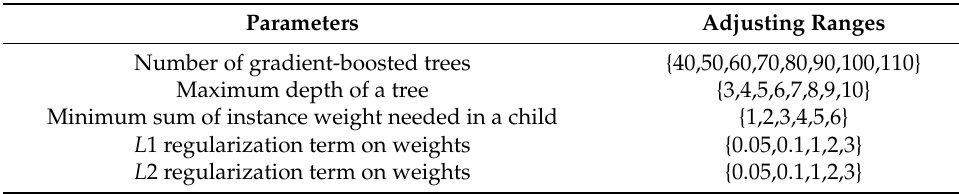
Table 2. Parameter tuning for XGBoost models.